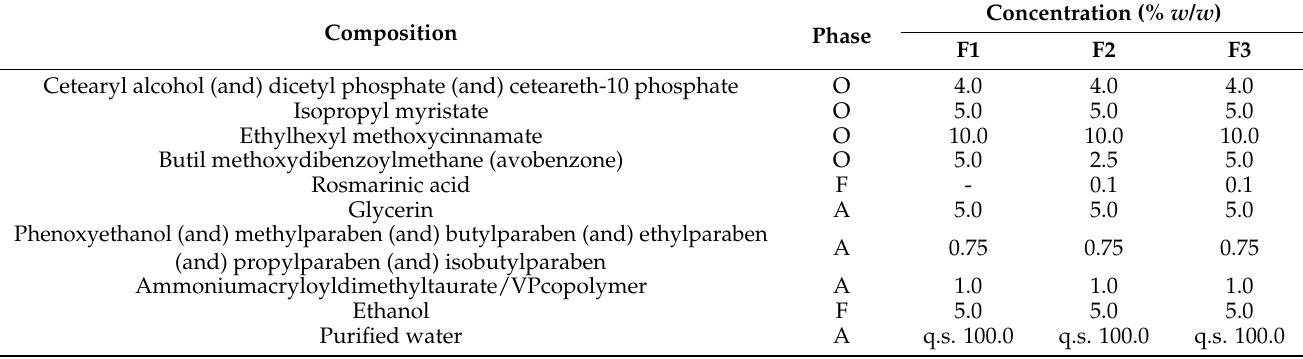
Table 1. Qualitative and quantitative (% w / w ) composition of